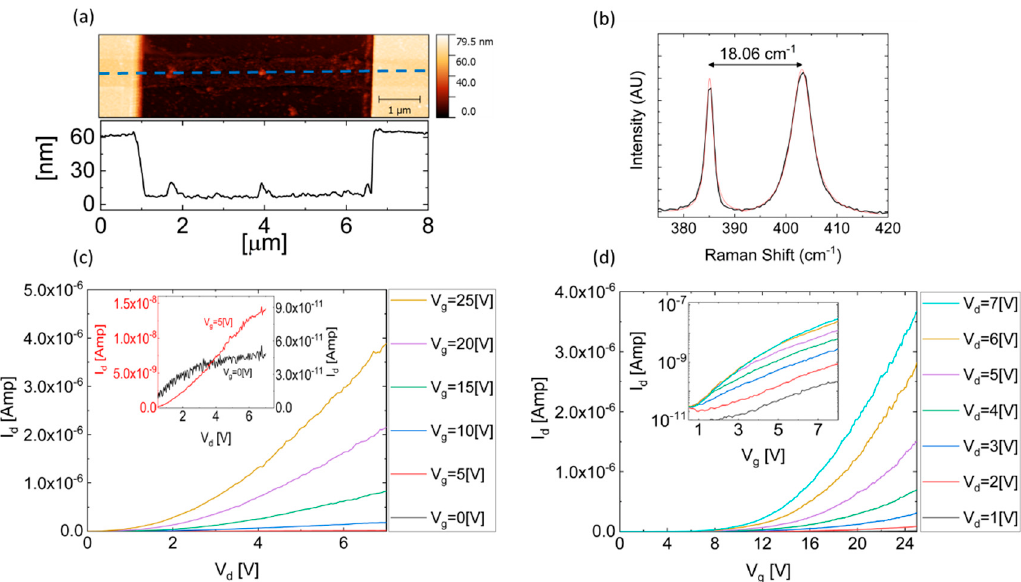
Figure 1. ( a ) An atomic force microscope (AFM) image, in addition to a topography profile along the dashed blue line, of the single-layer molybdenum disulfide (MoS 2 ) device. ( b ) Raman spectrum of the single-layer MoS 2 flake, presenting a separation of 18.06 cm − 1 between E 1 and A 1g . ( c ) I d ( V d ) characteristics of the single-layer MoS 2 field-e ff ect transistor (FET) device for several gate voltages, in addition to the magnified image in the inset, presenting the I d ( V d ) curves for V g = 0 V and V g = 5 V in blue and red, respectively. ( d ) I d characteristics of the FET device for several drain voltages, in both linear scale and logarithmic scale in the inset.